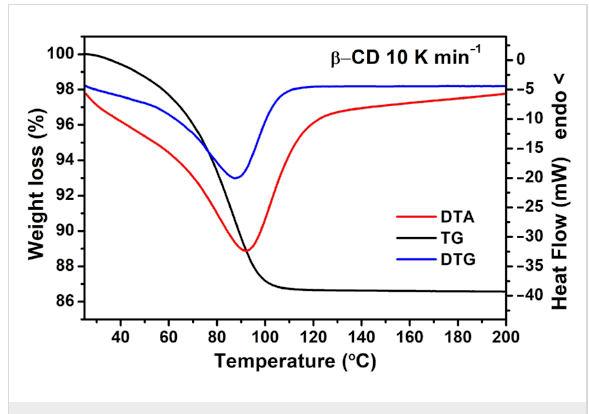
Figure 5: Thermal behavior of β